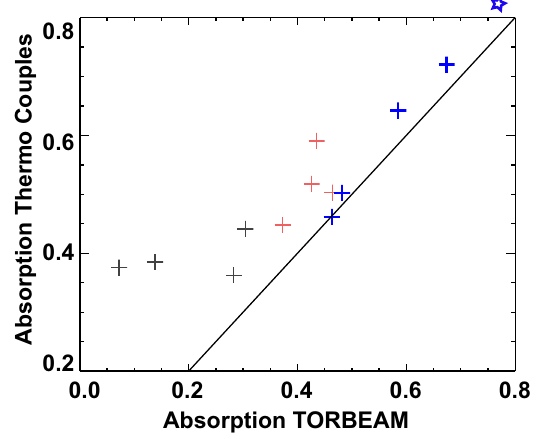
Figure 7. Comparison of the single-path absorption calculated by TORBEAM based on the n e , T e profiles determined with IDA to the single path absorption determined with the TCs. Grey crosses correspond to cases with increased main chamber recy- cling fluxes or light on the video from the reflector. Red crosses correspond to cases with increased HXR levels (here IDA used TS data for T e ). The blue crosses are the remaining undisturbed data. All data except the blue star are from beam 6, which has the most structured TC data, reducing the error in the power es- timation. The blue star corresponds to an early analysis of the 2 nd and 3 rd sweep with beam 8 in fig. 3 (TS data still to be re- analyzed with all the modeling established meanwhile [7]). The point is added here, since it corresponds to the highest single pass absorption achieved in the described